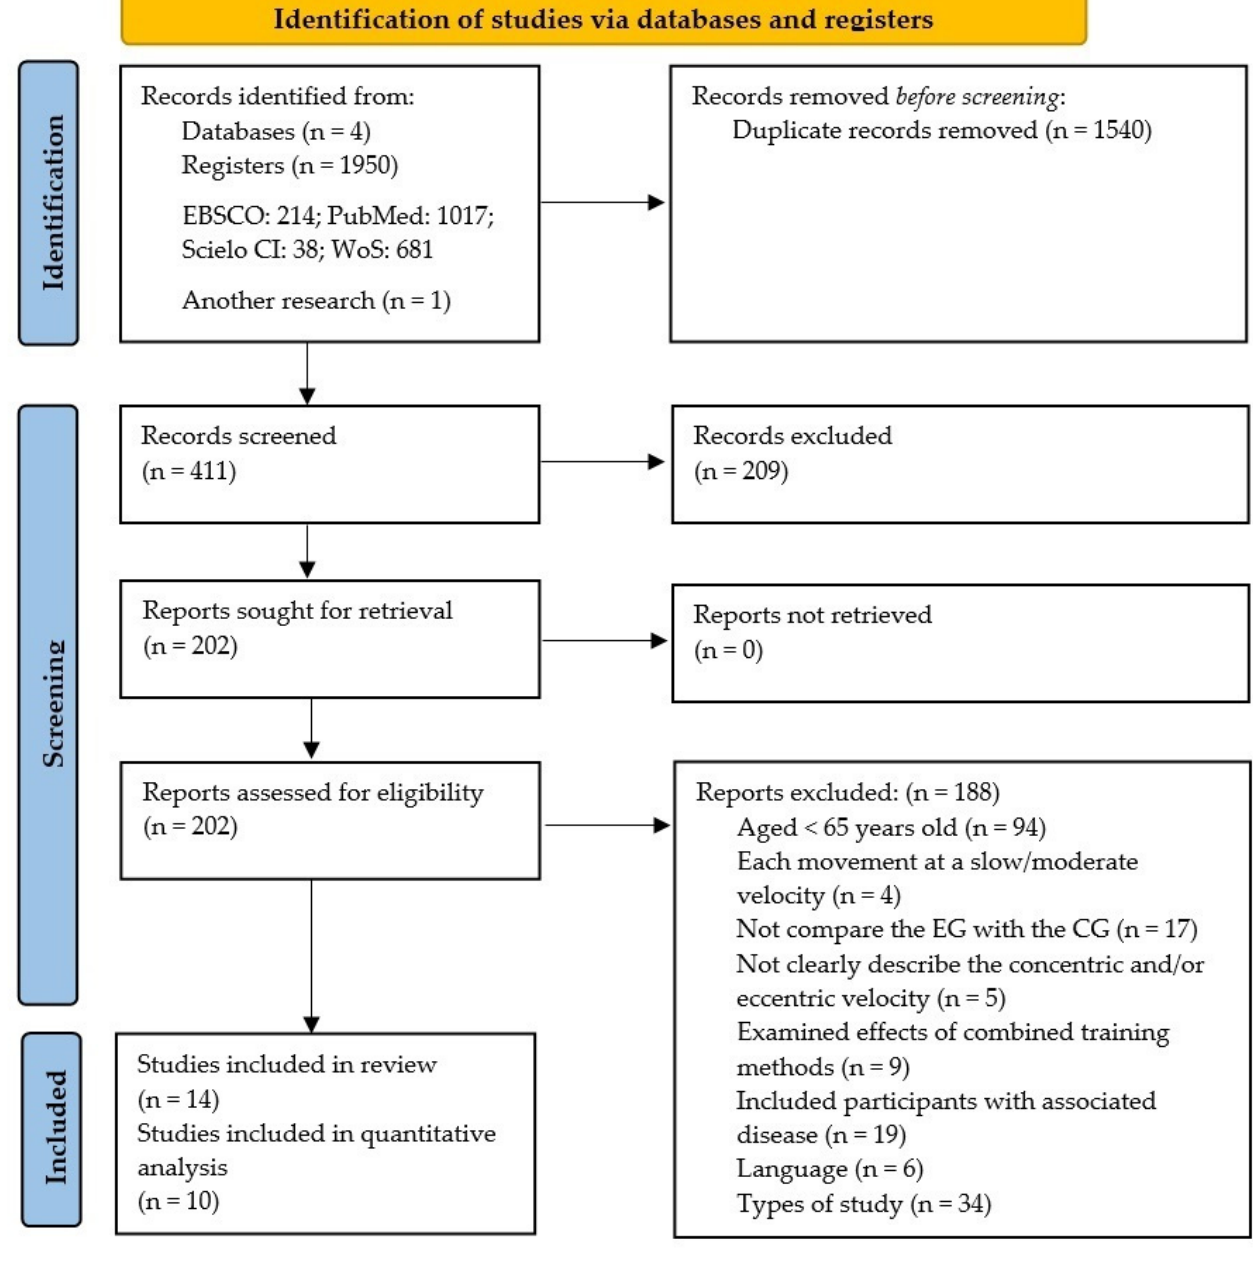
Figure 1. Flow chart of study design by PRISMA 2020.